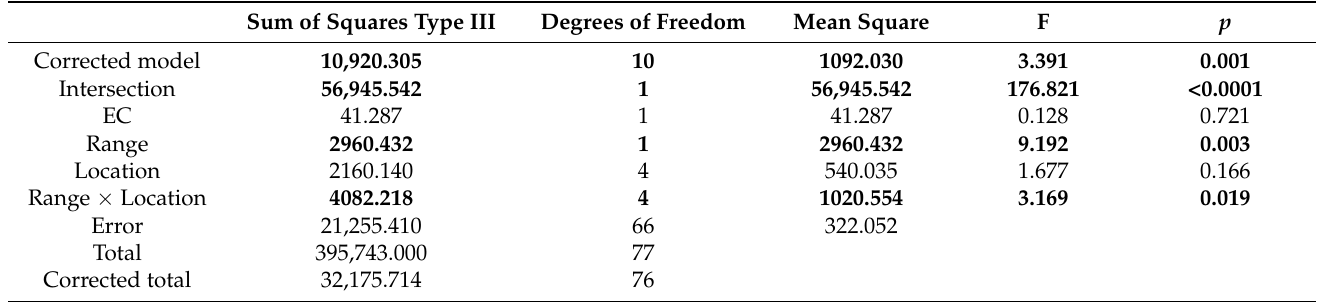
Table 2. General Linear Model for the relative cover of Iris pseudacorus comparing between distri- bution ranges (native and invaded) and population locations (ordered in each range sequentially according to their distance to the ocean), with sediment electrical conductivity (EC) as covariate. Significant differences are marked in